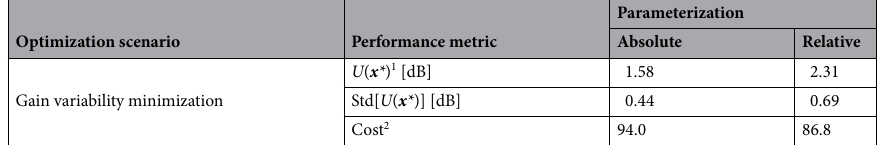
Table 6. Gain variability minimization results for Antenna I. 1 Optimized in-band gain variability, averaged over ten algorithm runs. 2 Number of EM simulations averaged over ten algorithm runs.